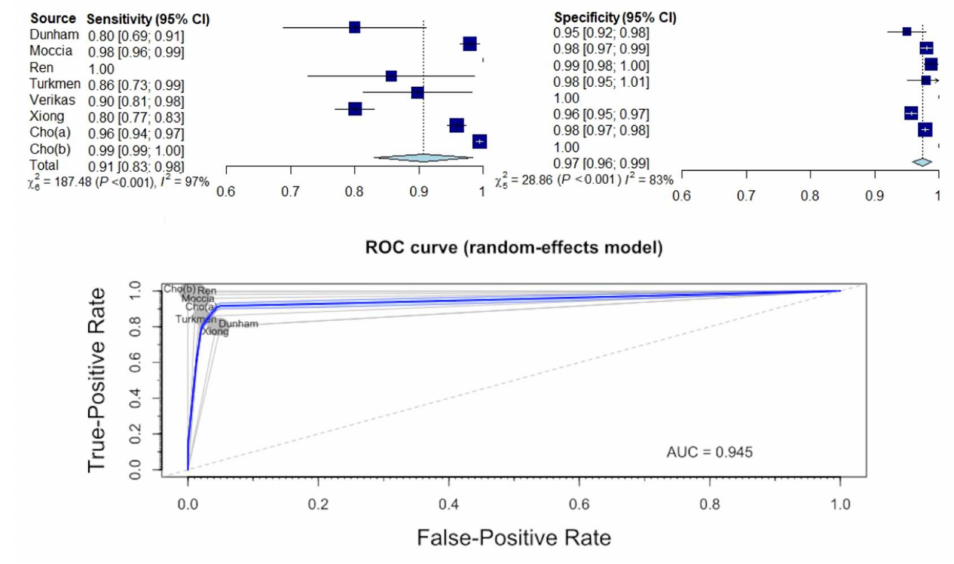
Figure 4. Forest plot and ROC curve illustrating the diagnostic performance of AI identifying healthy laryngeal tissue.